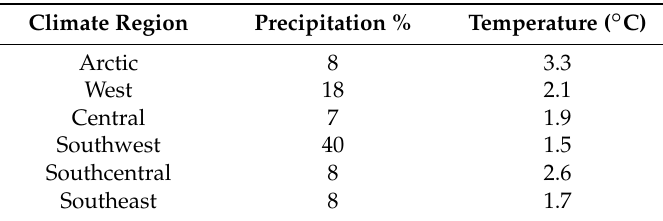
Table 1. Change in precipitation (%) and temperature ( ◦ C) for the climatic zones of Alaska from 1949–2016.